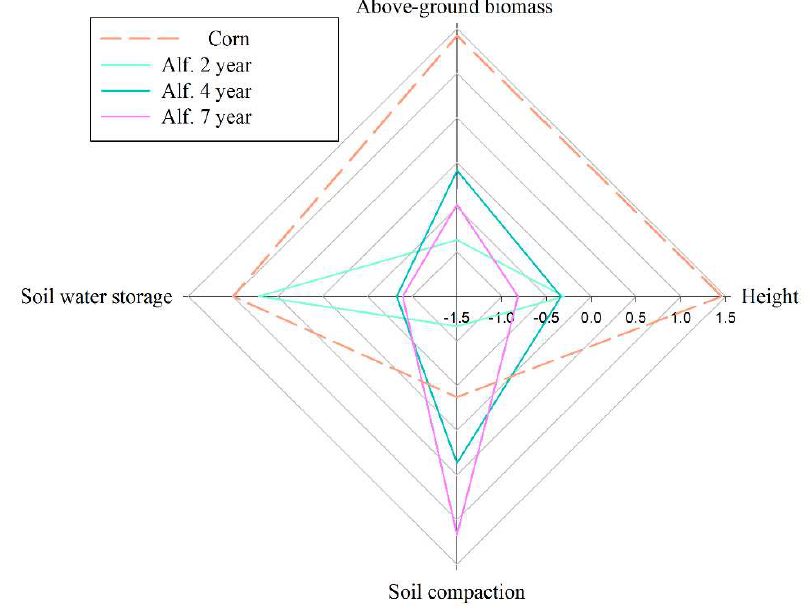
Figure 8. The comprehensive performance of soil compaction, soil water storage, vegetation height of the cornfield and the two-, four- and seven-year-old alfalfa pastures. The values of the four factors were standardized.